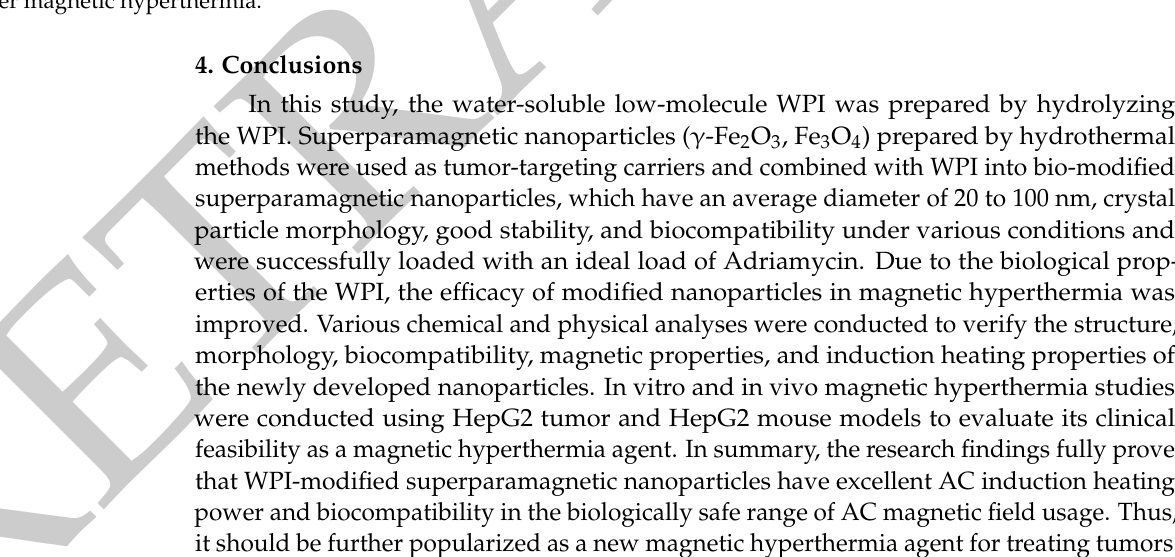
Figure 7. ( a ) Model of in vivo magnetic hyperthermia with mice carrying HepG2 tumors; ( b ) results of tumor temperature during in vivo magnetic hyperthermia; ( c ) model of high-energy thermal inductance (HETI) equipment for check result of tumor scale after in vivo magnetic hyperthermia; ( d ) set result of tumor scale: the first row using in vivo magnetic hyperthermia with WPI-Fe 2 O 3(85wt%) . The middle row using treatment with Adriamycin. The bottom row using treatment with normal saline; ( e ) the survival curve of mice at 0 day after magnetic hyperthermia; ( f ) the survival curve of mice at 7 days after magnetic hyperthermia.